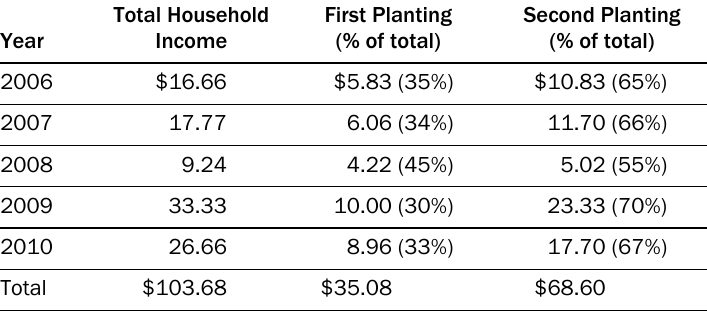
Table 2. Total of Household Income over a Five-Year Recall Period, 2006–2010, by Seasonal Planting (N=100) First Planting Second